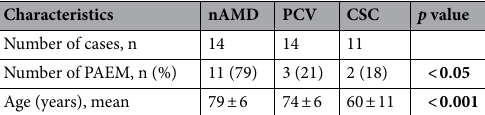
Table 4. Comparison of rate of PAEM and age between disease subtype. Significant values are in bold.